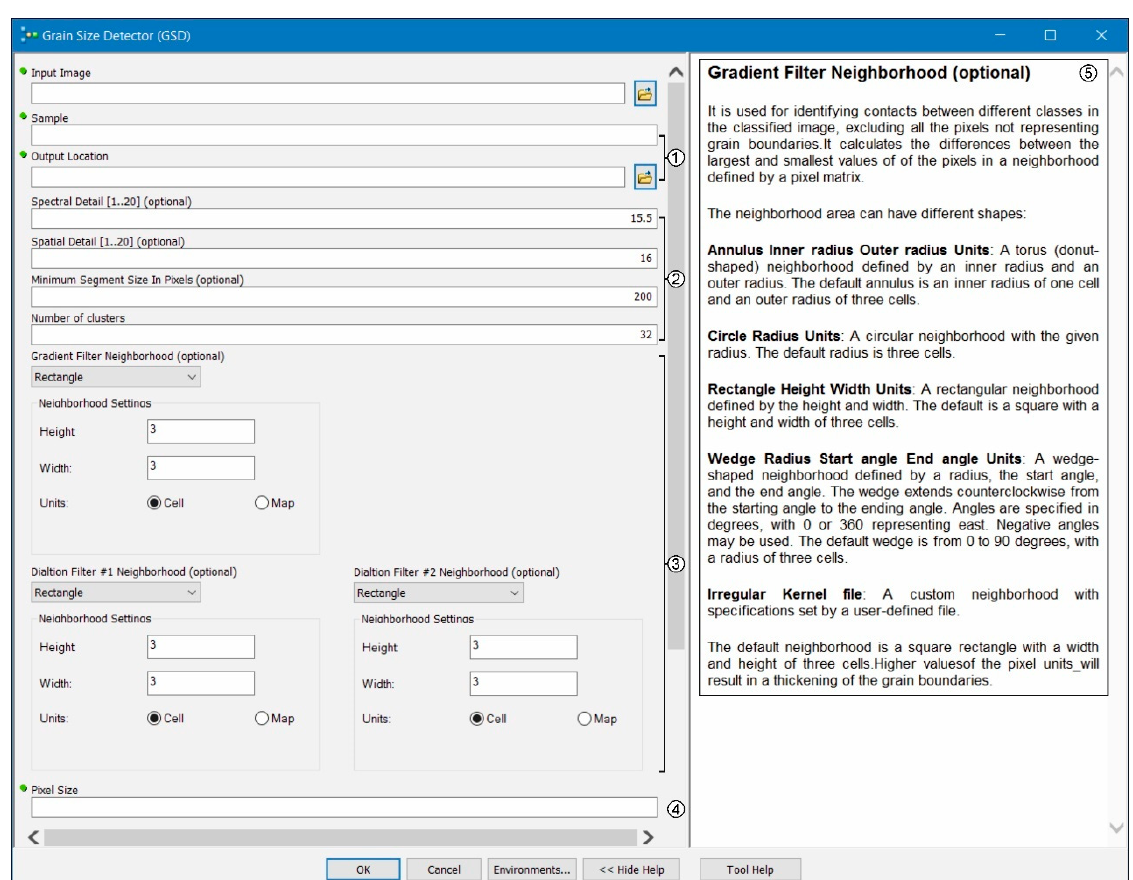
Figure 2. ArcGIS ® Graphical User Interface of the Grain Size Detector (GSD) tool: ( 1 ) the data storage management settings; ( 2 ) the image segmentation settings; ( 3 ) the edge enhancement settings; ( 4 ) the units of measure of the input image to be set for collecting measurements of grain data; ( 5 ) the help menu of the tool showing hints about the required inputs. Green circles on the left side mark mandatory inputs.